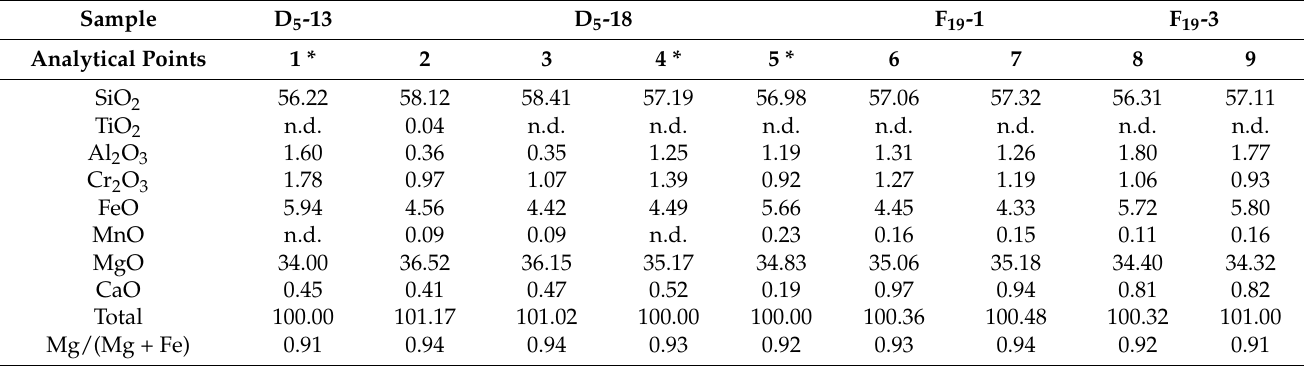
Table 5. The composition of monomineral orthopyroxene inclusions in chromite (wt.%).